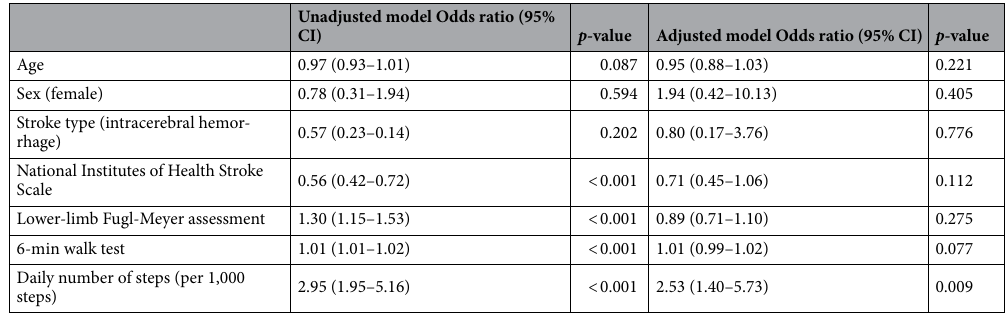
Table 3. Logistic regression analyses of association between average daily step count and walking independence.